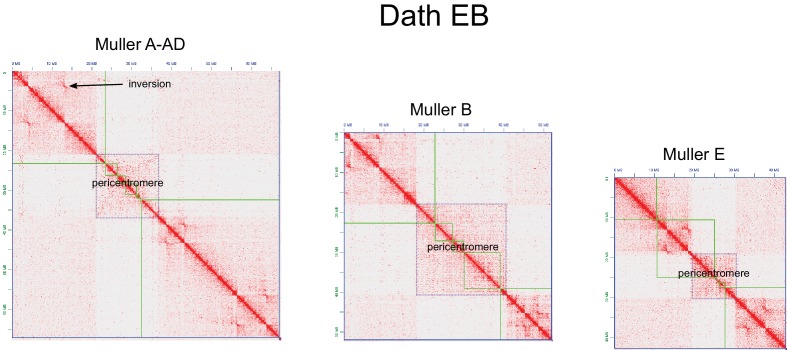
Drosophila athabasca EB metacentric chromosome Hi-C associations and scaffolding.Our EB assembly (Appendix 1—table 2) was superior to our EA assembly (Appendix 1—table 3) and long contigs from our EB assembly extended at least a megabase into the pericentromere for all metacentric chromosomes. Shown above are Hi-C association heatmaps from Juicebox (Durand et al., 2016a). Green boxes denote contigs. The pericentromeric region is highlighted in purple, and note the clear transition in Hi-C associations between euchromatic and heterochromatic regions. We used EA Hi-C data to scaffold the EB assembly. The EA and EB semispecies harbor inversions that differentiate the semispecies and we identified numerous inversions when mapping EA Hi-C to the EB genome assembly. Thus, the exceptionally long EB contigs that extend into the pericentromeric region allowed us to accurately scaffold chromosomes while simultaneously identifying inversions along the euchromatic arms.